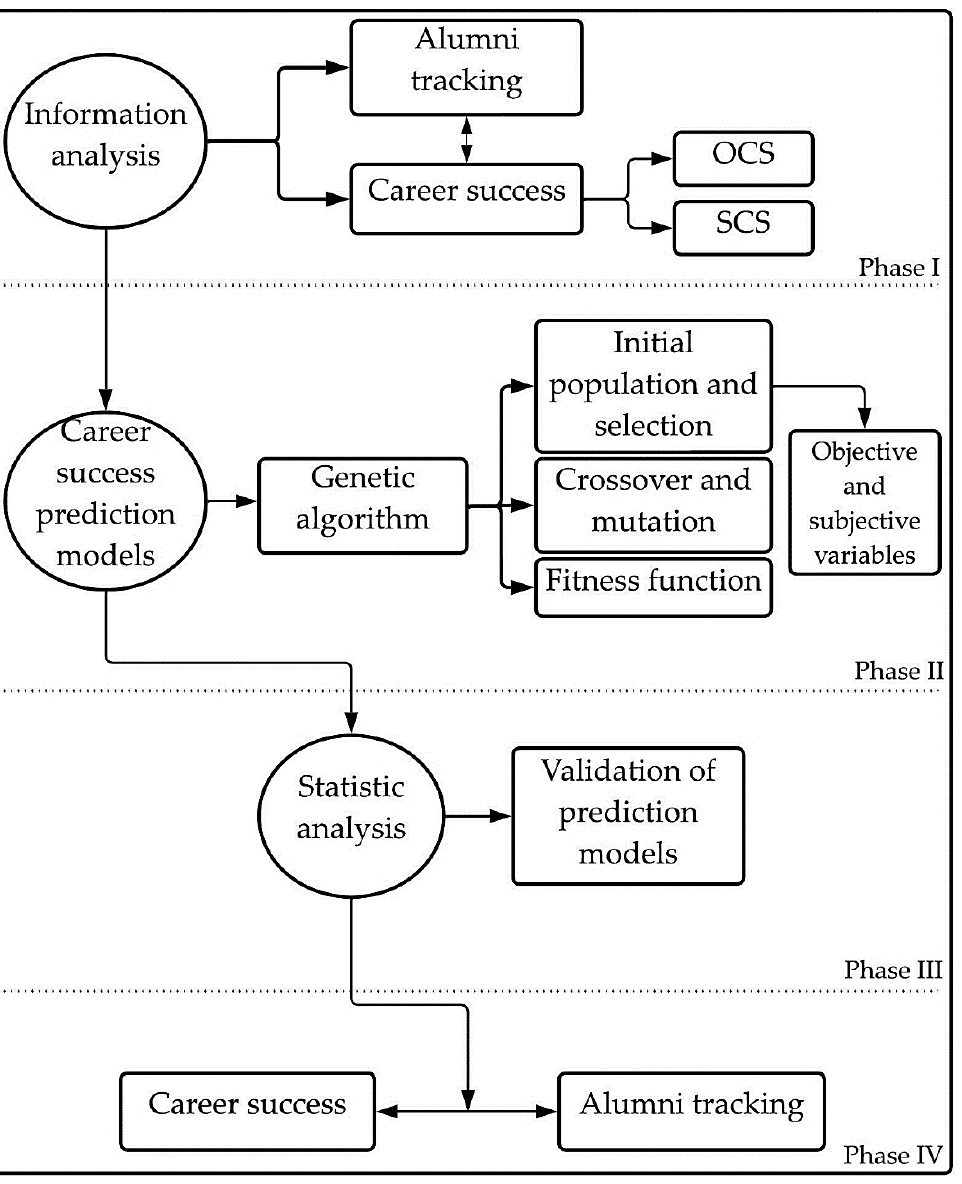
Figure 1. Research methodological design.